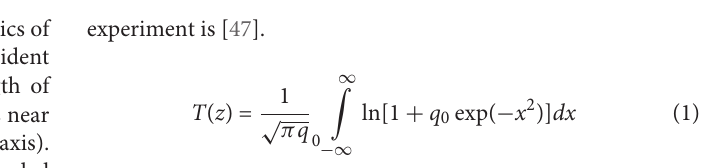
femtosecond laser is focused by a lens, with a focal length of 150 mm. A cuvette, containing as-prepared samples, moves near the focus in the direction of the laser-light propagation